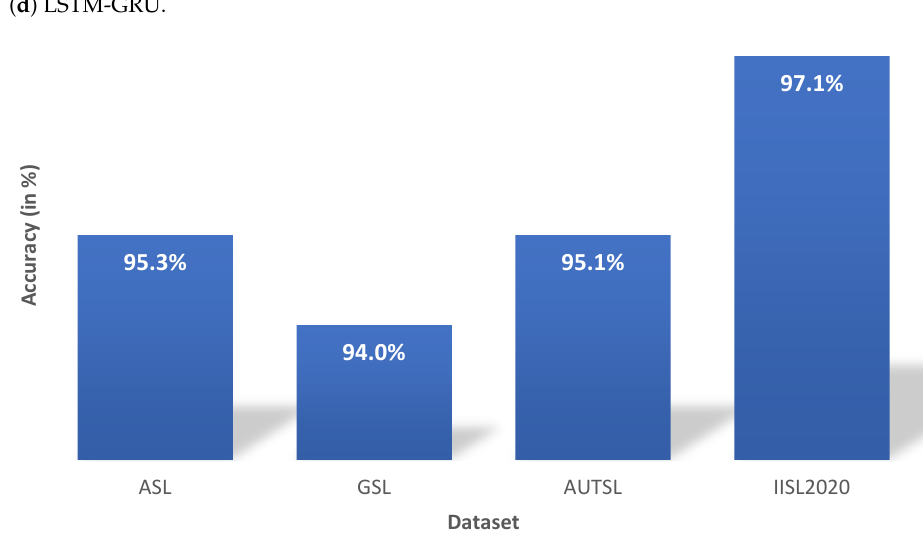
Figure 6. Implementation of the proposed model using different benchmark datasets.